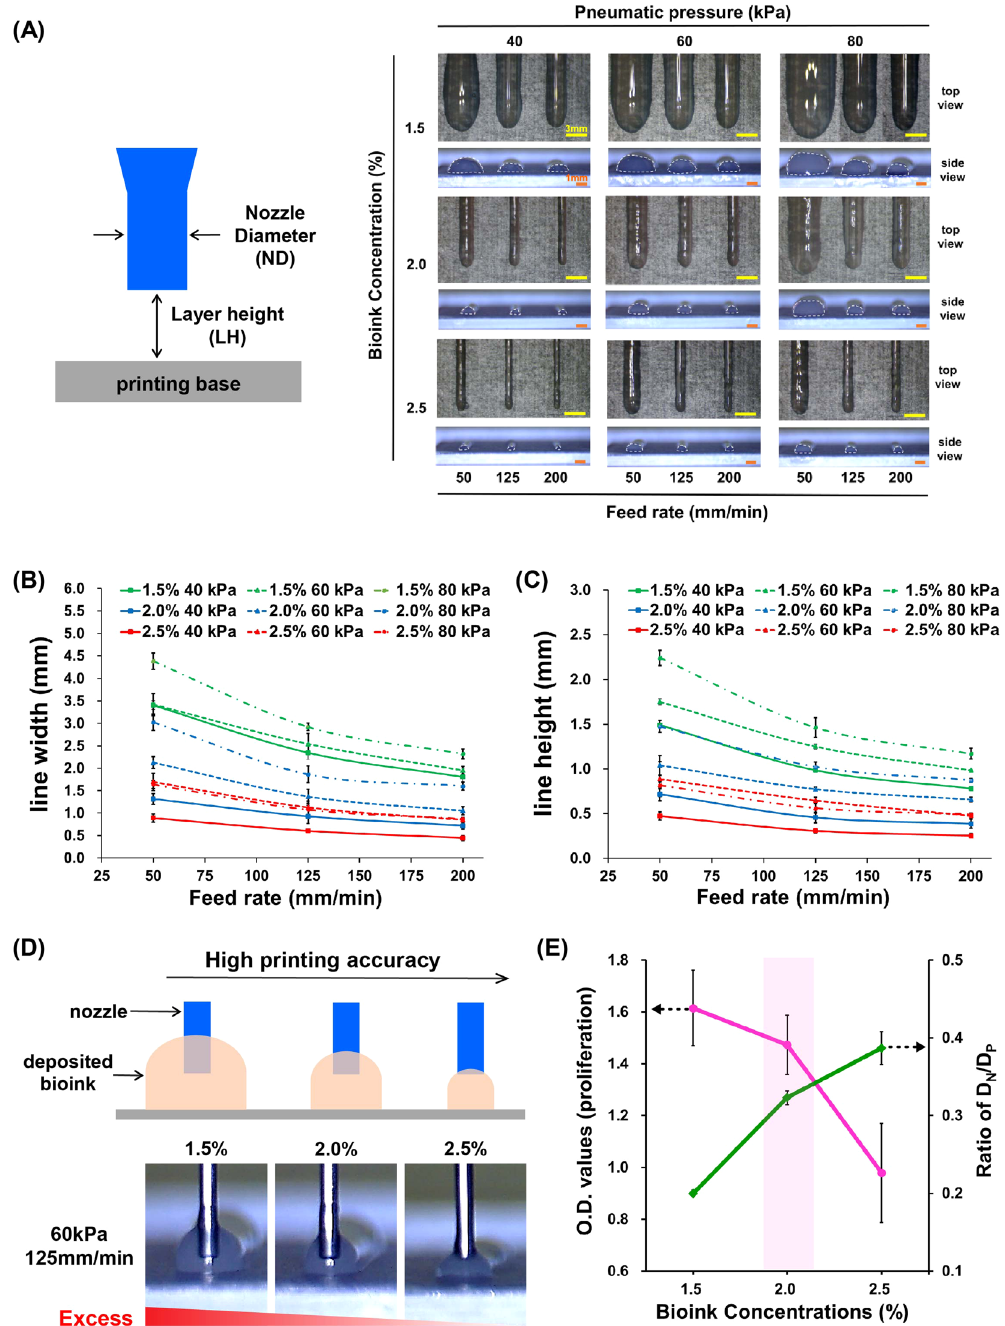
Figure 3. 2D patterning analysis. ( A ) Schematic diagram of printing settings and 2D patterning results depending on bioink concentrations and printing parameters. Quantitative analysis of the ( B ) width and ( C ) height of the printed straight lines. ( D ) Definition of printing accuracy and its representative optical images. ( E ) The relationship between cell proliferation and printing precision (ratio of D N /D P